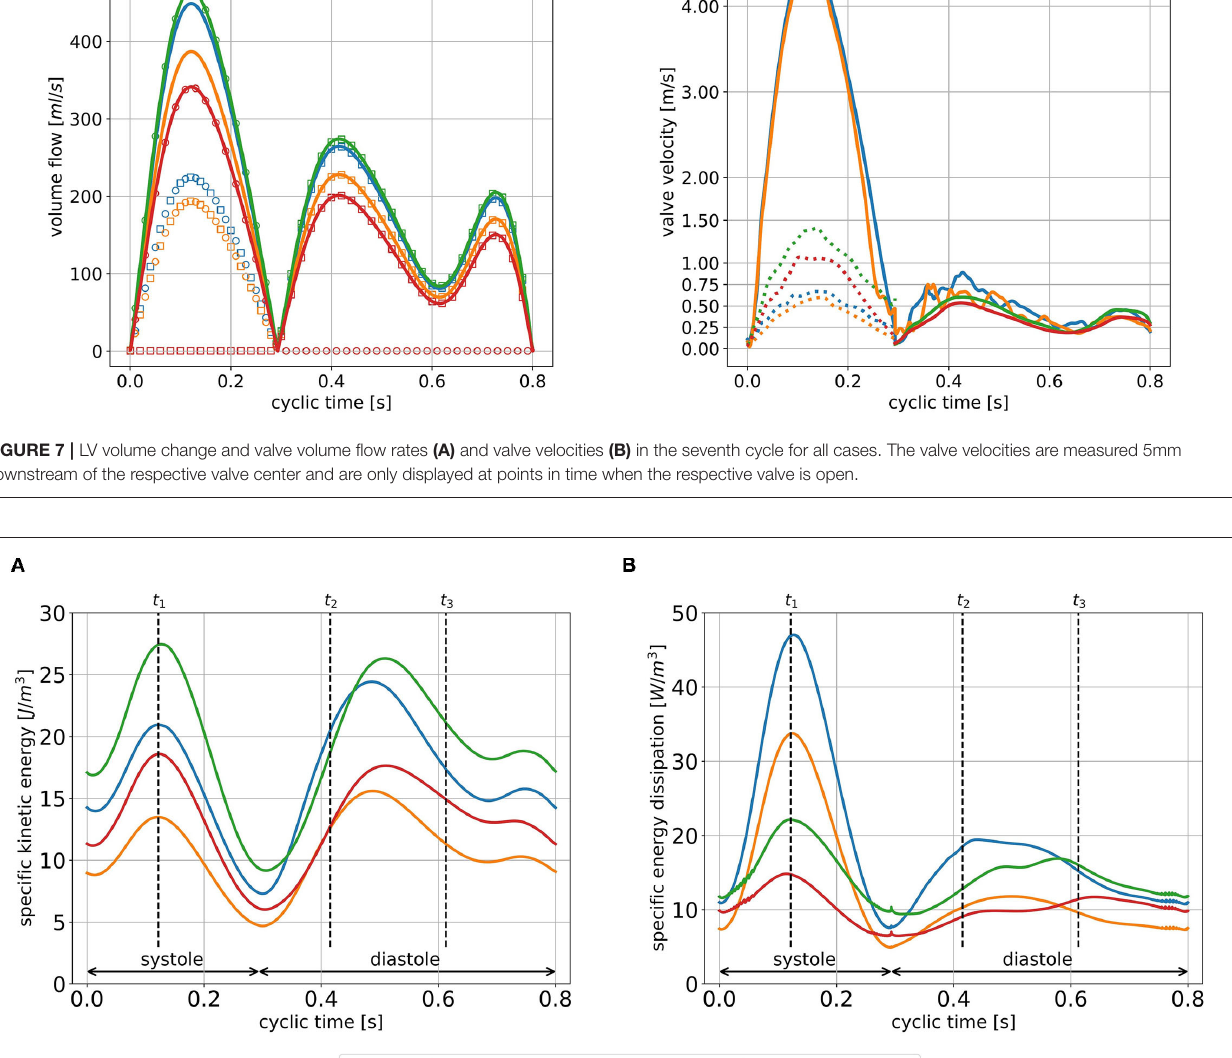
decreasing exponential shape, whereas the trend is linear in case M3A0. As a result, similar fractions of FCDIB inside the LVs are present at the end of cycle eight at 6.4 s ( Figure 9A ). A slightly worse washout is observed in the non-aneurysmatic cases M3A0 and M0A0. At the end of cycle eight, approximately 5 % more FCDIB are still present in the LVs in the non-aneurysmatic